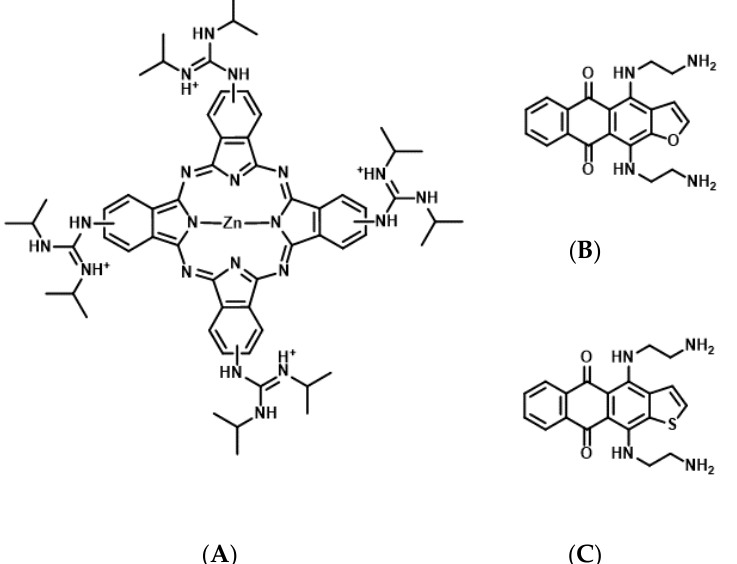
Figure 4. Chemical structures of tetrakis-(diisopropyl-guanidine) phthalocyanine (Zn-DIGP) ( A ), anthrafurandiones (ATFD) ( B ), and anthrathiophenediones (ATPD) ( C ).